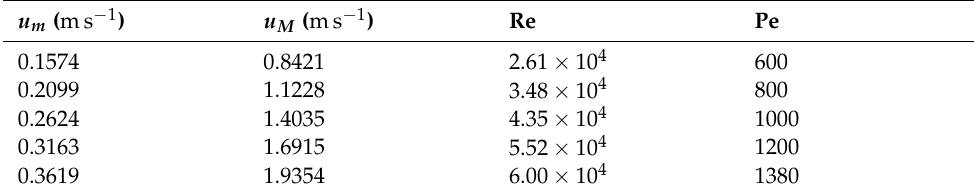
Figure 2. Geometry and boundary conditions for the numerical model used to recreate the results of Abramov et al. for the compact bank [14]. The vertical spaces between adjacent rods are called vanes and are labeled, in descending order, from no. 1 to no. 4. Table 2. Parameter range for the validation test